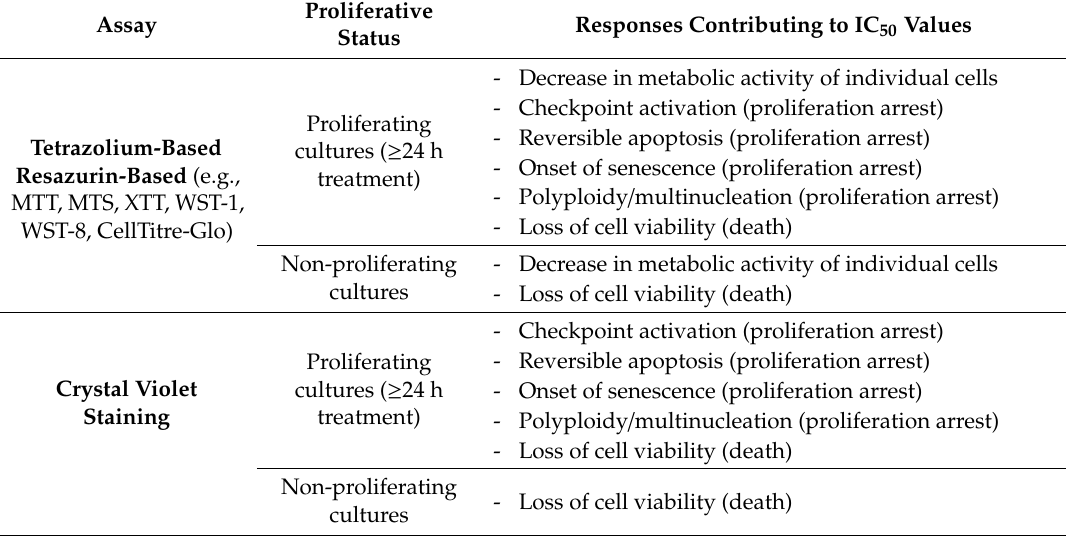
Table 1. Genotoxic stress-induced responses that contribute to reduction in colorimetric / fluorometric measurements in multiwell plate assays in proliferating versus non-proliferating cultures. Proliferative Responses Contributing to IC 50 Assay